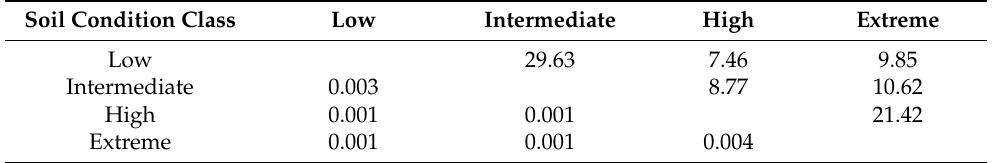
Table 3. PERMANOVA pairwise comparisons of bryophyte species composition between soil con- dition classes. Lower diagonal— p -values by permutation. Upper diagonal—average similarities between